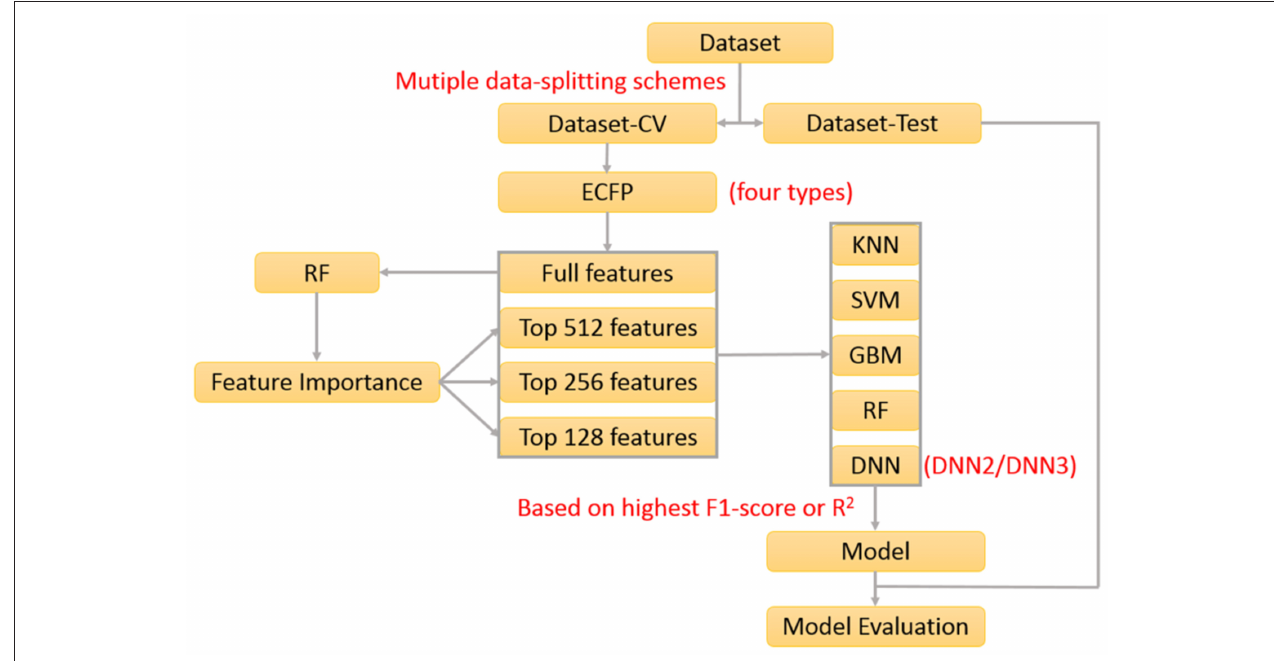
FIGURE 1 | The protocol to derive the classification and regression model used in this work.